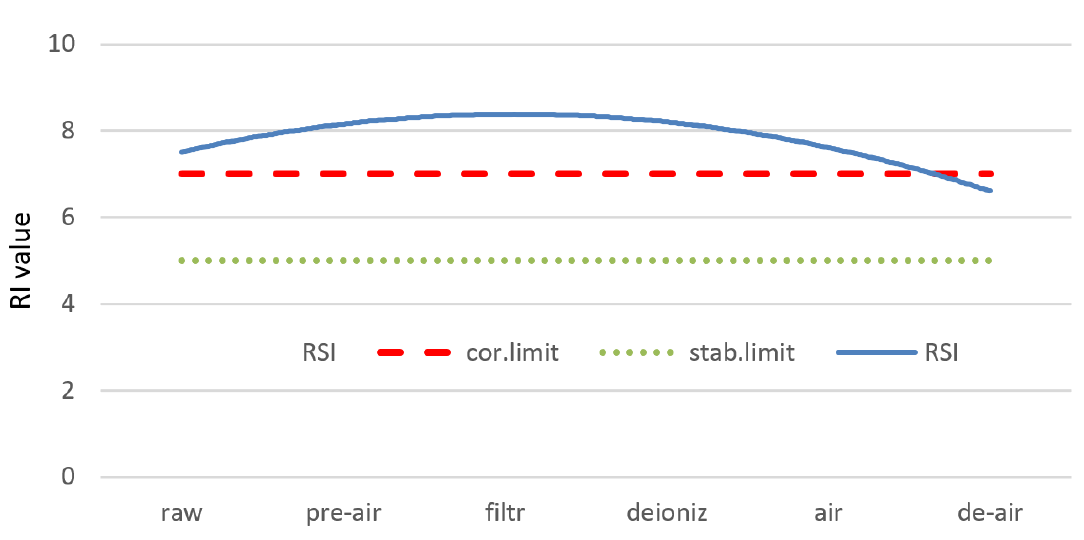
Figure 4. Changes of Ryznar Stability Index (RI). Source: Own elaboration.